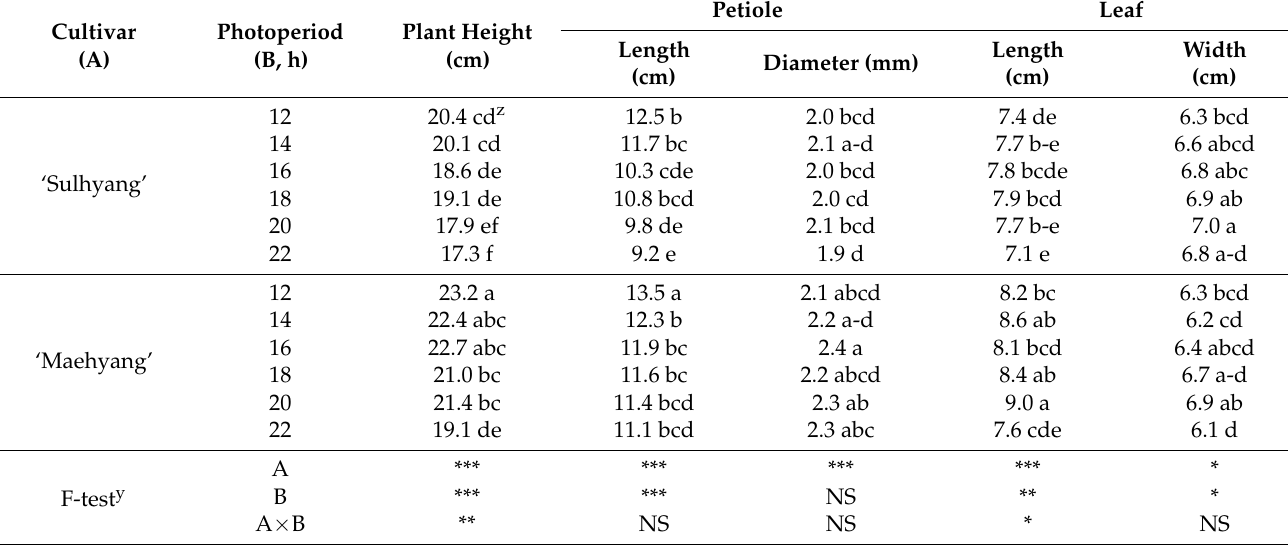
Table 1. The growth parameters of strawberries as affected by the photoperiod.